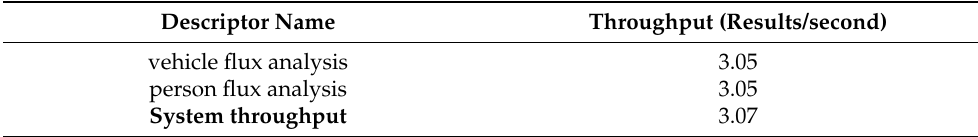
Figure 13. Composition of the processing pipeline for the crowd/traffic monitoring application. Table 2. Descriptor throughput resulting for the crowd/traffic monitoring application experiment conducted on a single node, with one worker for vehicle flux analysis and one for person flux analysis